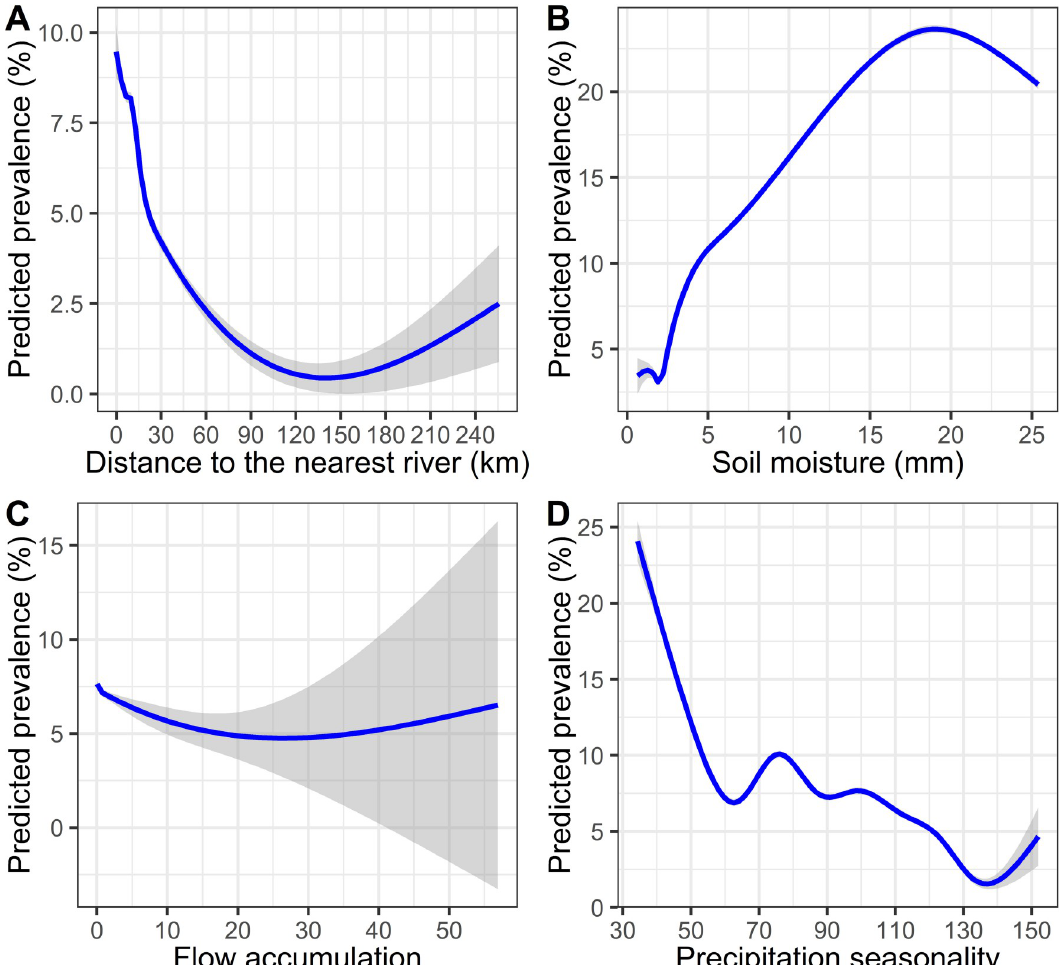
Fig 5. The relationship between the predicted posterior mean prevalence with the significant environmental covariates. The curve was fitted using the gam smoothing function available in the ggplot2 package for the purpose of visualization. The shaded region around each curve represents the 95% confidence interval. Flow accumulation had a range of high magnitude compared to other covariates (values ranged from 0 to 100418). Thus, this variable was rescaled from 0 to 100 to make its range comparable with other